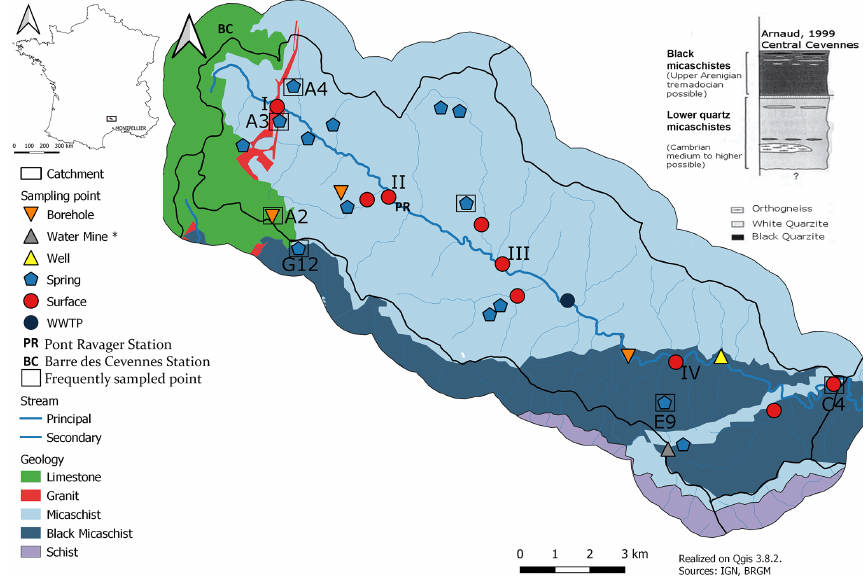
Figure 1. Geology of the watershed studied: Gardon of Sainte-Croix. * A water mine is a horizontal well dug on the mountain slope.